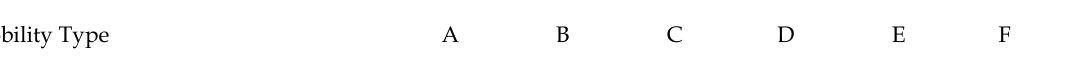
Selecting the best mobility type